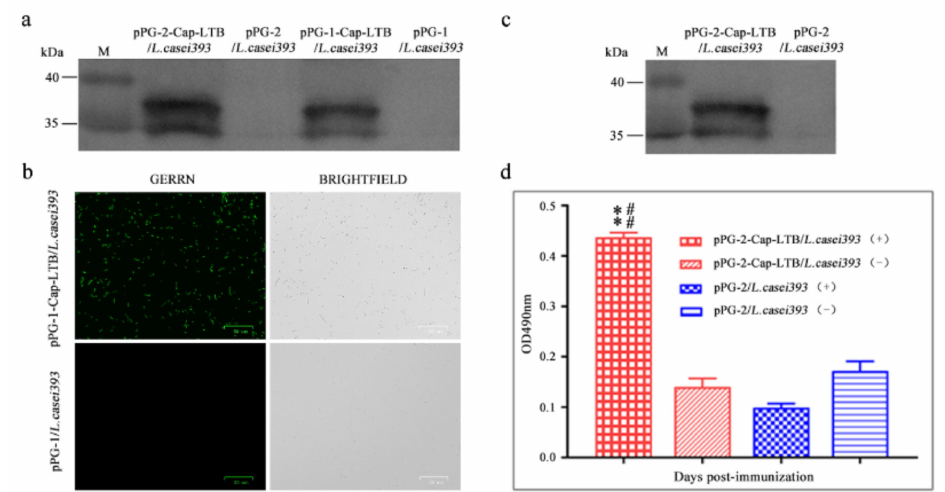
Figure 2. Analysis of the expression of the protein of interest of recombinant L. casei 393 strains. ( a , b ) Fusion protein expression on the surface of the cells was analyzed via Western blotting and immunofluorescence using rabbit anti-Cap serum; ( a ) The results show a relevant immunoreactive band in pPG-1-Cap-LTB/ L. casei 393 and pPG-2-Cap-LTB/ L. casei 393 , but none in the empty cells. M: protein molecular weight markers; ( b ) There was a green fluorescent signal on the cell surface of strain pPG-1-Cap-LTB/ L. casei 393 , but not of strain pPG-1/ L. casei 393 , indicating that the protein of interest was expressed and displayed successfully on the surface of recombinant LAB; ( c , d ) Fusion protein secretory expression at the supernatant of the cells was analyzed via Western blotting and indirect ELISA using rabbit anti-Cap serum. Bars represent the mean ± standard error value of each group (* p < 0.05, ** p < 0.01 compared to the control groups: pPG-1/ L. casei 393 and # p < 0.05, ## p < 0.01 compared to group: pPG-2/ L. casei 393